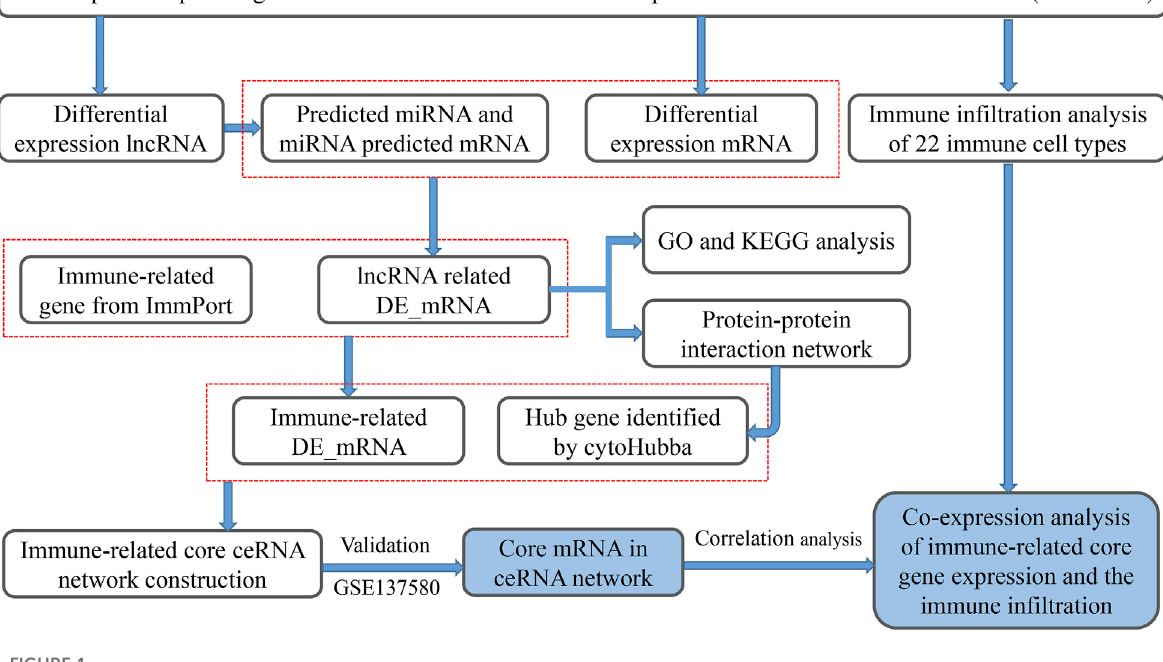
FIGURE 1 Schematic representation of our analytic